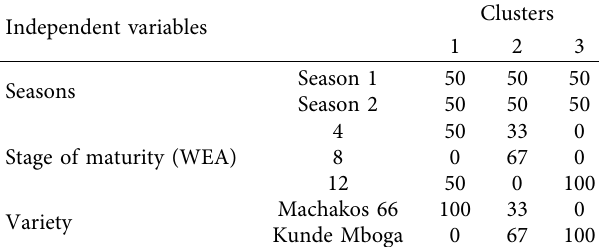
Table 6: Loading of independent variables for optimization of stage of maturity of cowpea leaves in clusters.